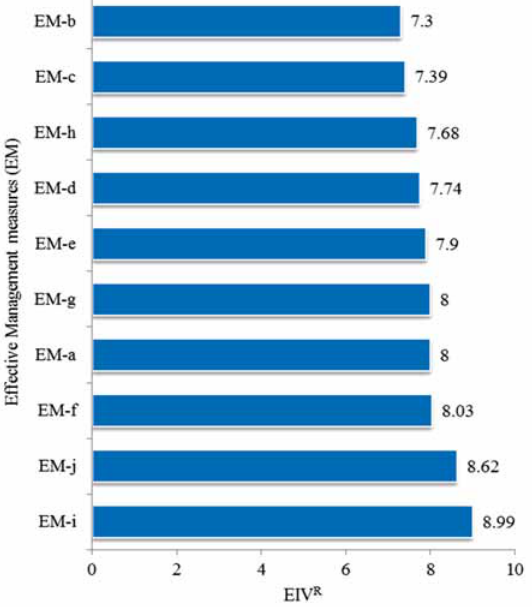
Fig. 3. Ranking profile of the strategic implementation measures perceived by Nigerian construction